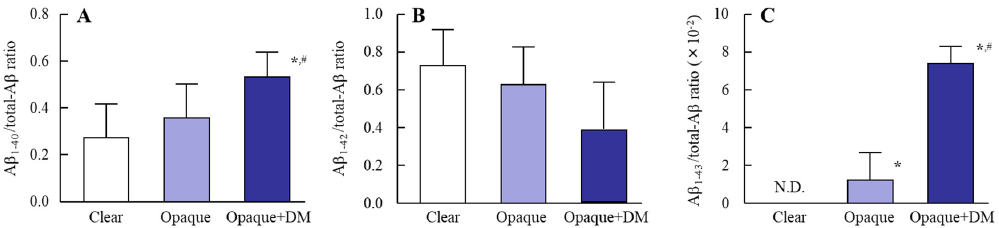
Figure 2. Changes in A β 1–40 /total-A β ( A ), A β 1–42 /total-A β ( B ), and A β 1–43 /total-A β ( C ) ratios in lens epithelium of diabetic patients. Patient characteristics are shown in Table 1 (ELISA method group). Open columns, transparent lens epithelium; closed columns, opaque lens epithelium. Clear, transparent lens epithelium; opaque, opaque lens epithelium; opaque + DM, opaque lens epithelium with type 2 DM. N.D., not detectable. n = 5–18. * p < 0.05, vs. clear for each group. # p < 0.05, vs. opaque for each group.